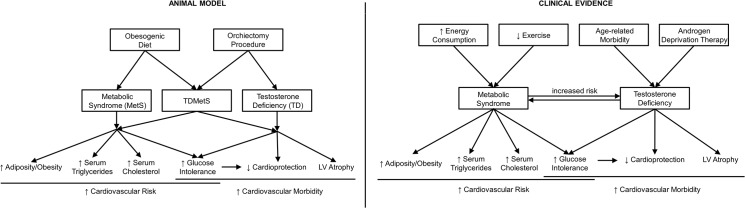
Summary of the animal model and clinical evidence of Testosterone-deficient Metabolic Syndrome (TDMetS).
The animal model described in the present study received an obesogenic diet which induced the metabolic syndrome (MetS) by increasing adiposity, circulating triglycerides and cholesterol; and contributing to glucose intolerance. Orchiectomy procedures induced testosterone deficiency (TD) which impaired cardioprotection and also contributed to glucose intolerance in these animals. The combined model of testosterone-deficient metabolic syndrome (TDMetS) demonstrated all characteristics described in both the MetS and TD models. Clinical evidence supports the strong associations between MetS and TD and the impact of the combined TDMetS phenotype which is comprehensively represented in our animal model and results in an adverse cardiovascular risk profile and a complex myocardial pathology.